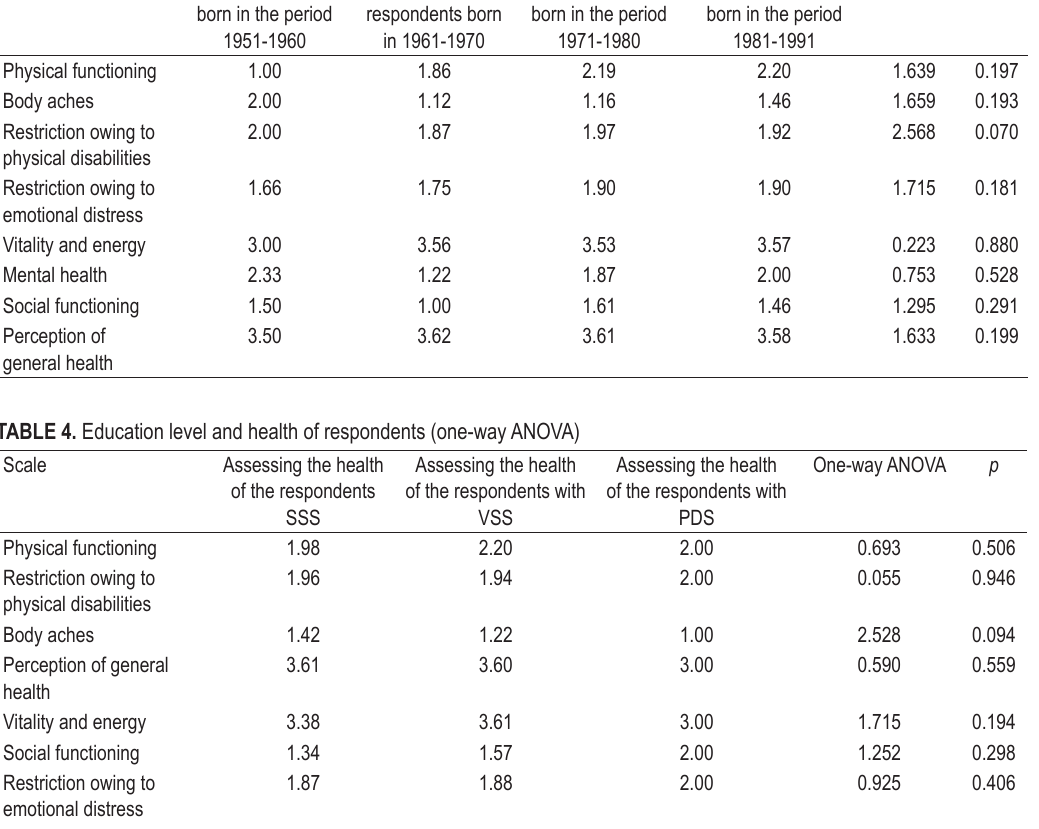
TABLE 3. Age and health of respondents (one-way analysis of variance [ANOVA]) Scale